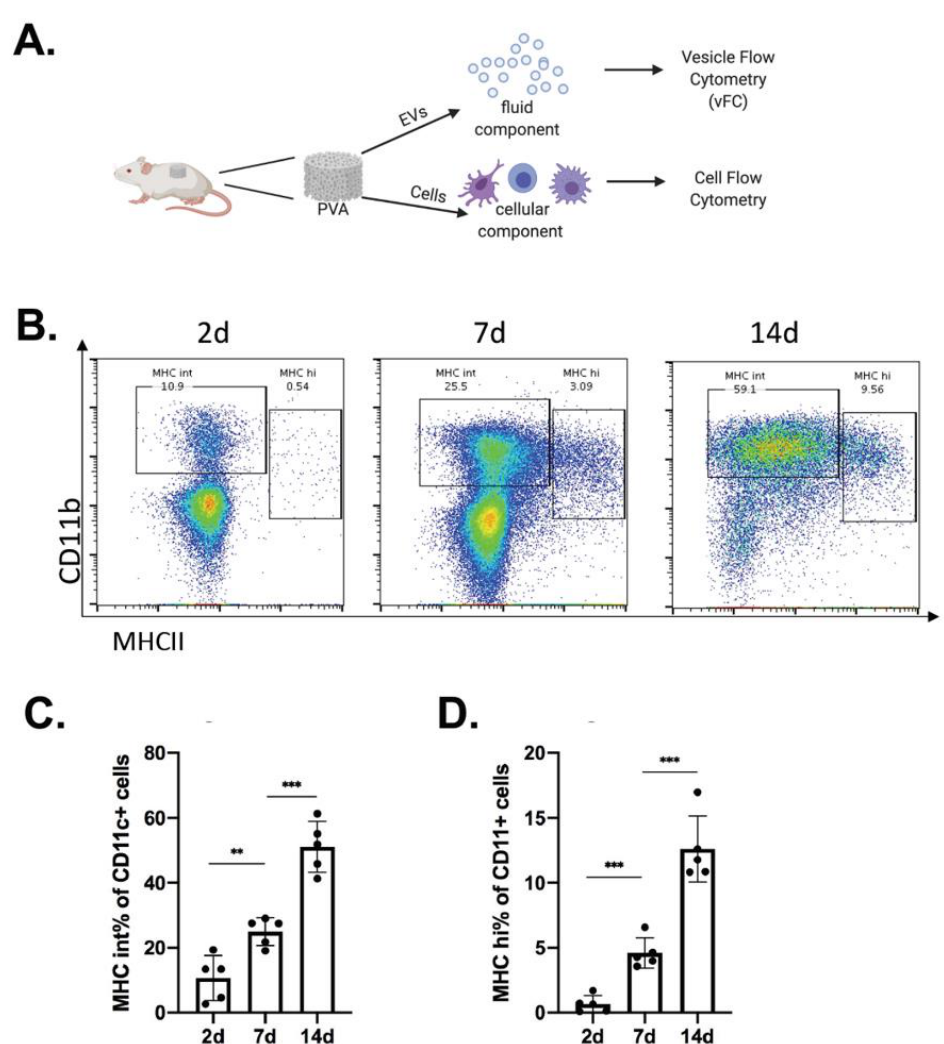
Figure 1. Kinetics of immune cell recruitment in the in vivo foreign body response using immune competent mice. ( A ) Subcutaneous implants of PVA sponge were used as a model of sterile inflam- mation were immune cells were isolated and analyzed by flow cytometry to define cell types, and the wound fluid used for subsequent EV analysis. ( B ) To focus on myeloid-derived immune cells, representative dot plots of events that were first gated on CD11c + cells to identify the relevant subset of cells to analyze, and the kinetics changes in surface levels of CD11b and MHCII determined at 2, 7, and 14 days post-implantation. ( C ) Quantification of changes in the numbers of CD11c + cells expressing intermediate levels of MHCII (MHCIIint), ( D ) changes in cells expressing high levels of MHCII (MHCII hi ). Data shown are mean ± SD. ( n = 5; ** p < 0.01 and *** p < 0.001).